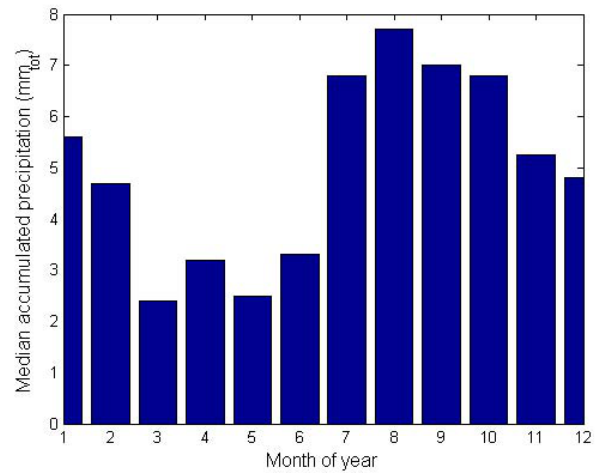
Fig. 14. Monthly median of accumulated precipitation experience by trajectories arriving at Svalbard during the period of 2000–2010.